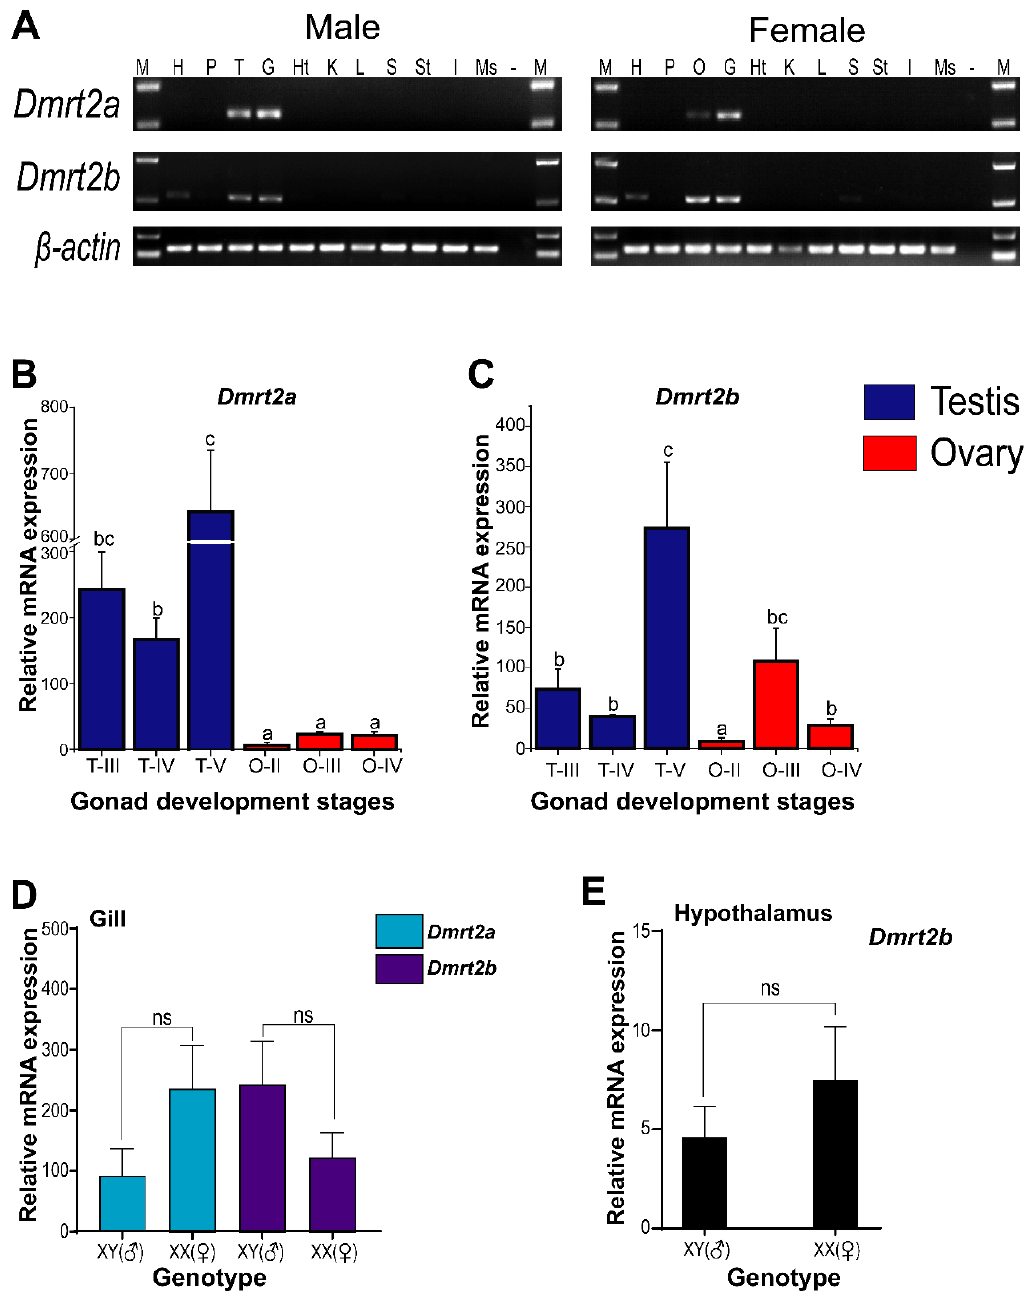
Figure 6. The mRNA expression levels of Dmrt2a and Dmrt2b from different tissues of adult spotted scat by PCR and qPCR. ( A ) Tissue distribution of Dmrt2a and Dmrt2b. β -actin was used as an internal control. M, DNA marker; H, hypothalamus; P, pituitary; T, testis; O, ovary; G, gill; Ht, heart; K, kidney; L, liver, S, spleen; St, stomach; I, intestine; Ms, muscle; −, negative control. Gene expression patterns of spotted scat Dmrt2a and Dmrt2b mRNA in gonads at different development stages ( B , C ). Gene expression patterns of spotted scat Dmrt2a and Dmrt2b mRNA in the ( D ) gills and ( E ) hypothalamus. Here, β -actin was used as an internal control for gene normalization, and the 2 −ΔΔCt method was used in gene expression calculation. The data are expressed as the means ± standard deviations of at least triplicates. Different letters indicate means with significant differences ( p < 0.05), and ns indicate no statistically significant difference ( p > 0.05). “T” and “O” indicate testis and ovary, respectively. The roman numerals II, III, IV, and V represent gonad development stages (stage 2, 3, 4, and 5, respectively). XY ( ♂ ) and XX ( ♀ ) represent male and female, respectively.